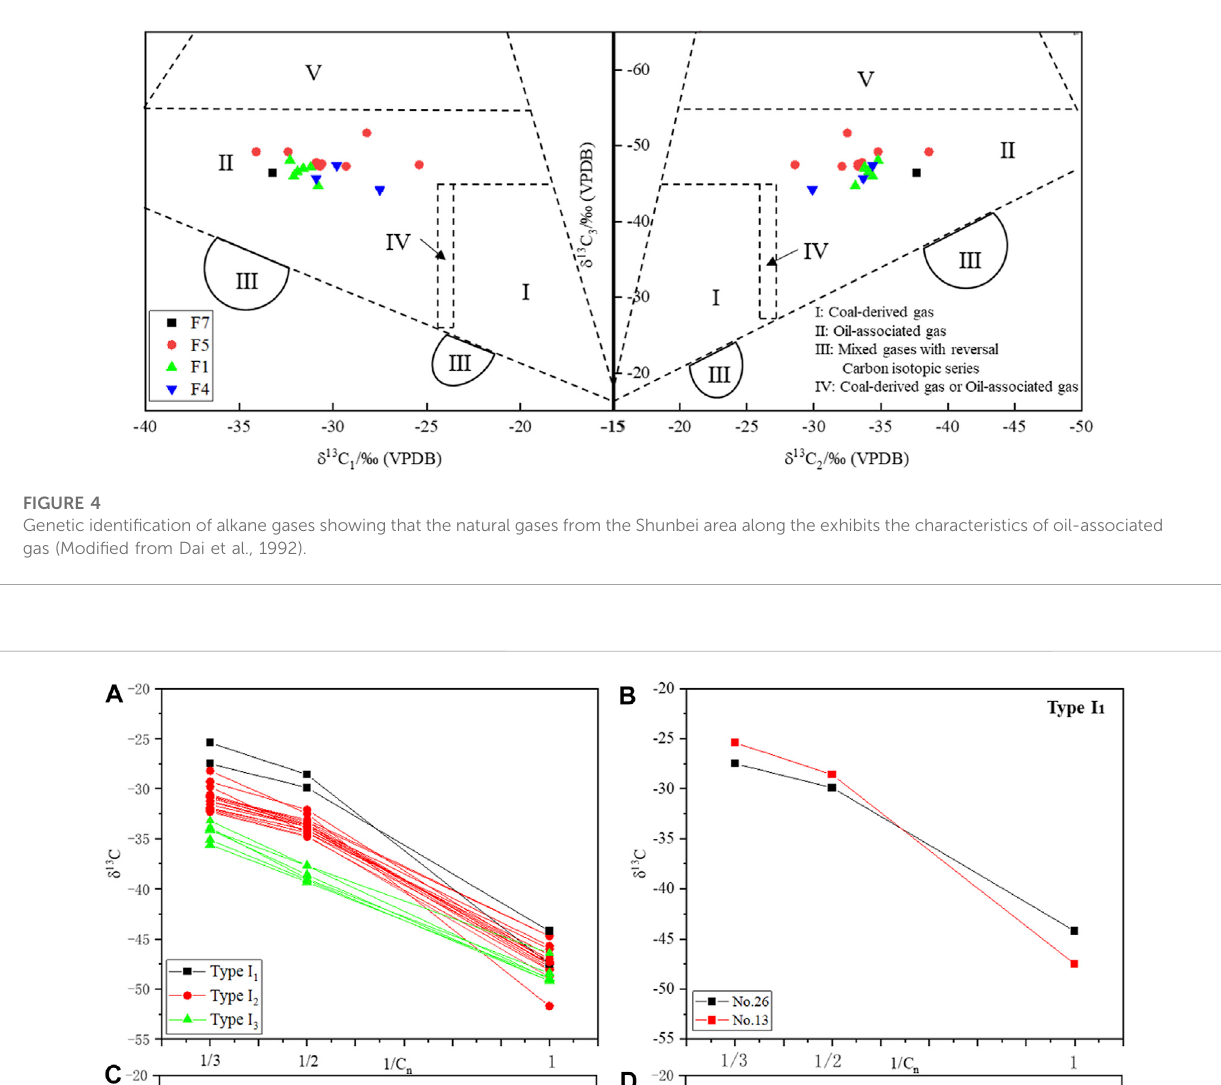
Frontiers in Earth